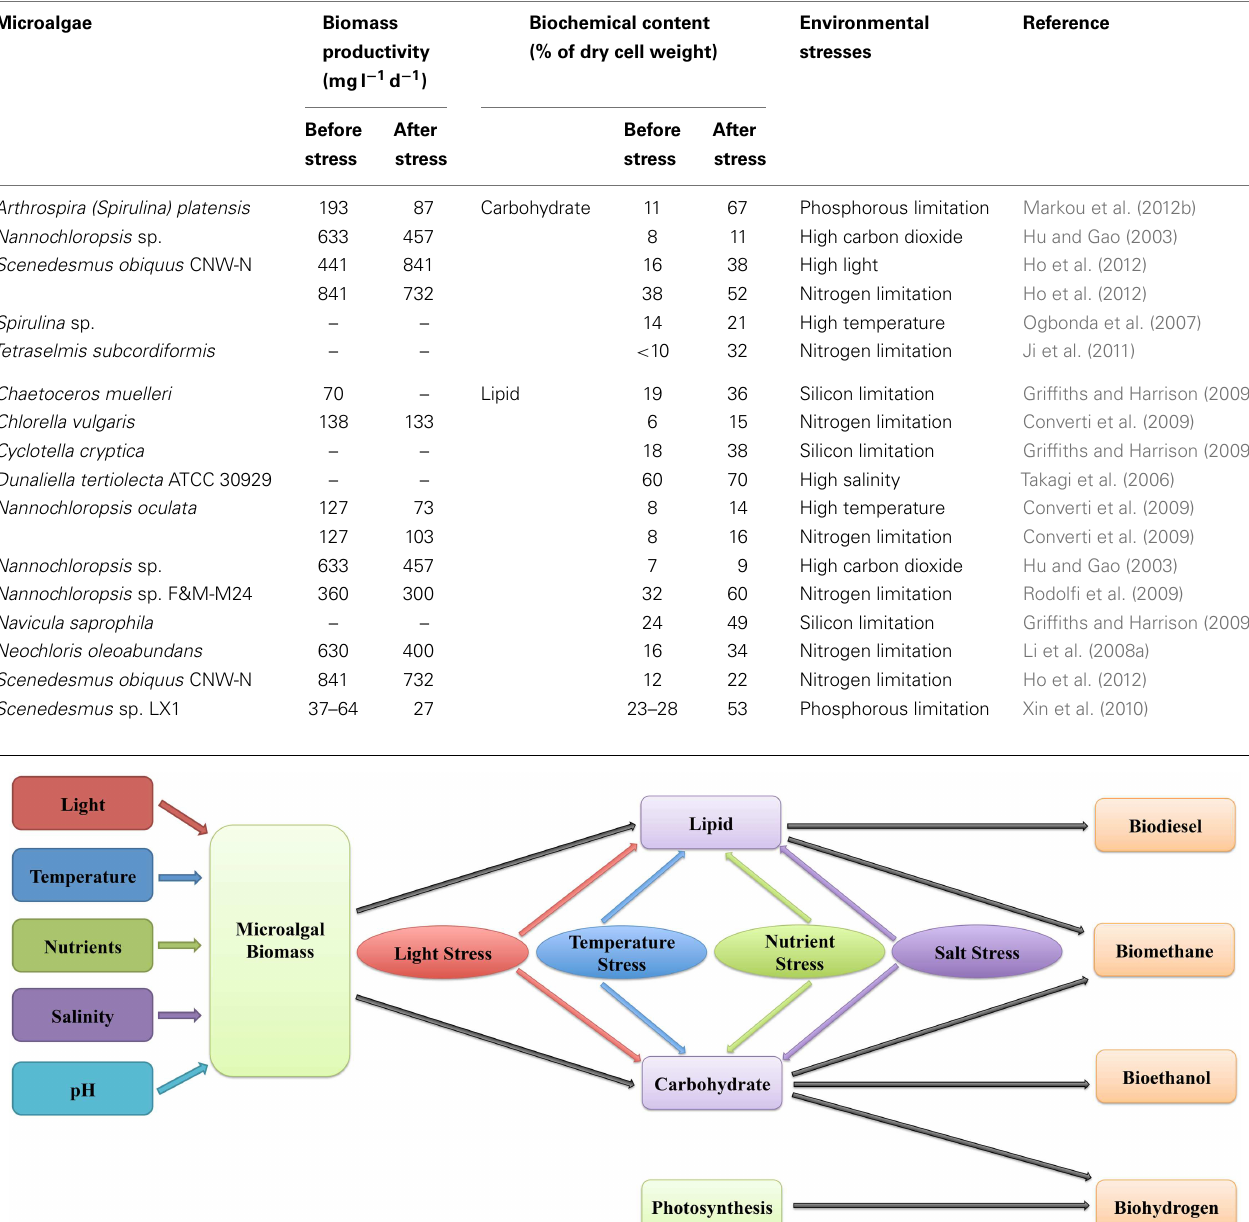
Table 1 | Impact of environmental stresses on microalgal biomass accumulation and biochemical composition for biofuels .